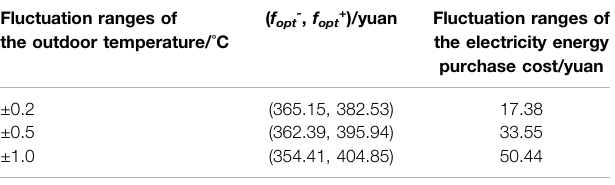
TABLE 4 | Electricity energy purchase costs under different outdoor temperature fl uctuation ranges. Fluctuation ranges of the outdoor temperature/ ° C